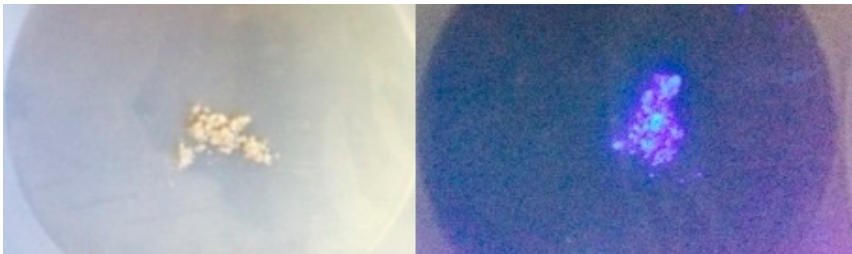
Figure 10. Luminescence of 7 (fumaric acid) 4 as revealed in photographs of microcrystalline samples taken under ambient light ( left ) and UV light (365 nm) ( right ).